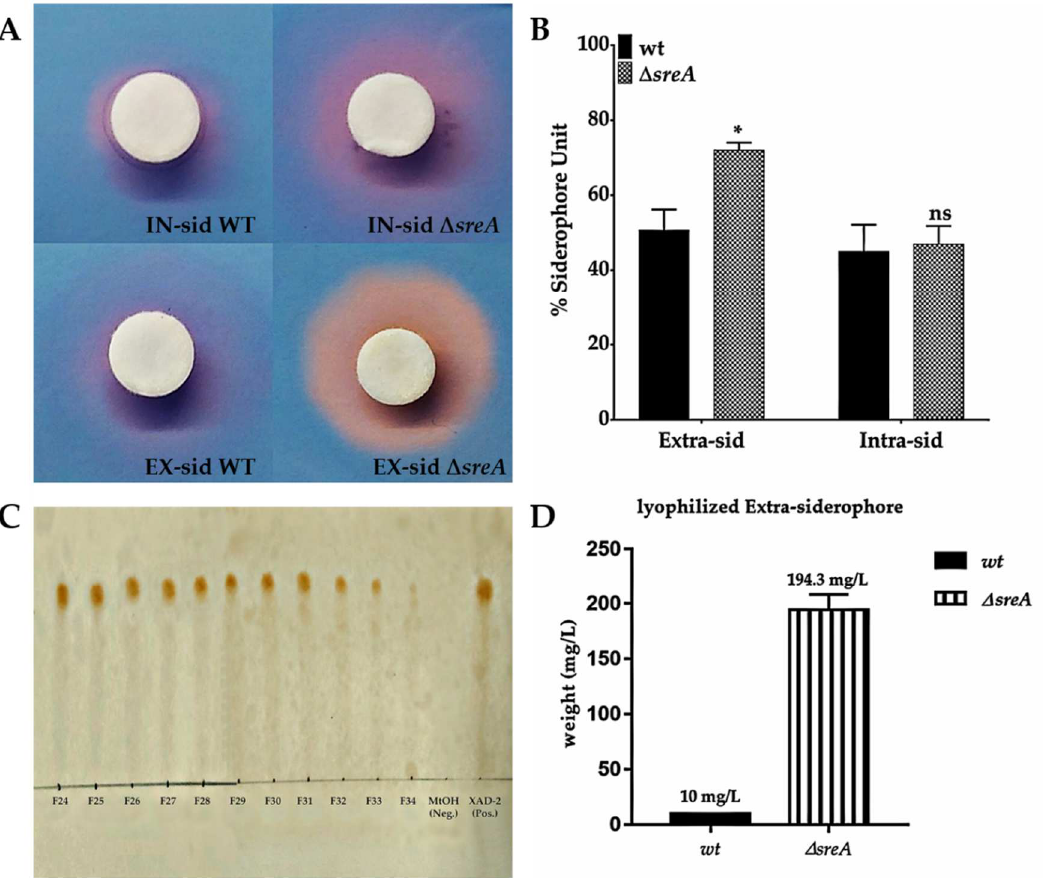
Figure 2. Detection of siderophores produced by T. marneffei strains. The halo zone of intracellular and extracellular siderophores was observed by Chrome azurol S (CAS) agar assay ( A ). Intracellular and extracellular siderophores levels were measured by CAS liquid assay ( B ). Thin-layer chromatographic analysis of purified fractions ( C ). The stationary phase was TLC silica gel 60 F 254 , the mobile phase was a solvent mixture of n-butanol: acetic acid: DI water (12:3:5 , v / v / v ). Developing agent was 0.1 M FeCl 3 in 0.1 N HCl. The siderophore activity of Δ sreA mutant was compared with the T. marneffei wild type. The weight of the lyophilized compound was measured from T. marneffei ∆ sreA strain compared with wild type ( D ). The significant levels were determined by the unpaired t -test. Asterisk (*) indicates the difference between wild type and ∆ sreA , p -value < 0.0001.